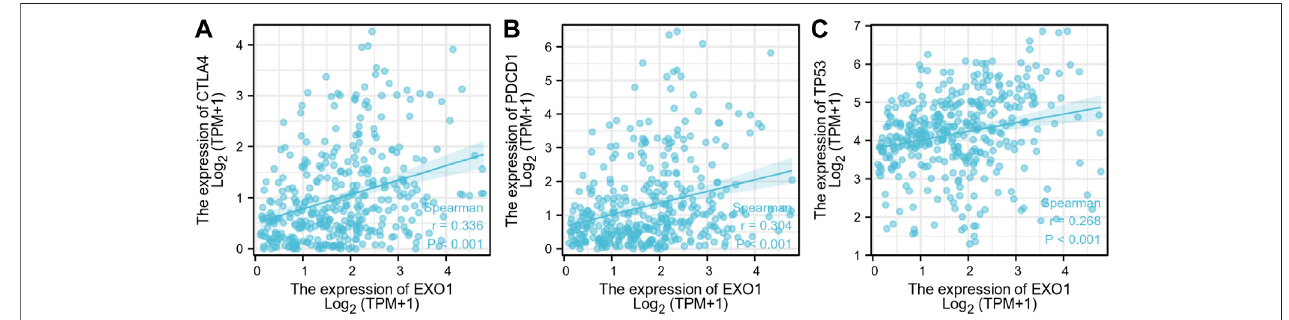
FIGURE 4 | The correlation analysis between the expression levels of EXO1, CTLA-4, PDCD-1, and TP53 in HCC. (A – C) The correlation analysis results between the expression levels of EXO1 and the expression levels of (A) CTLA-4, (B) PDCD-1, and (C) TP53 in the TCGA-LIHC